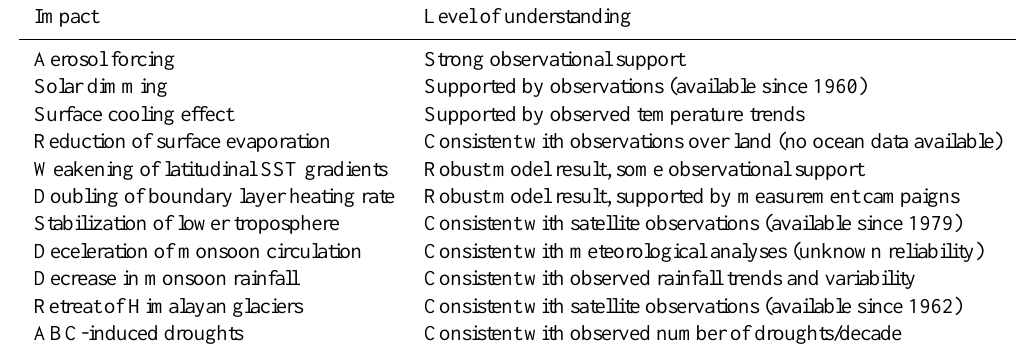
Table 9. Climate impacts of the SAW-ABC.